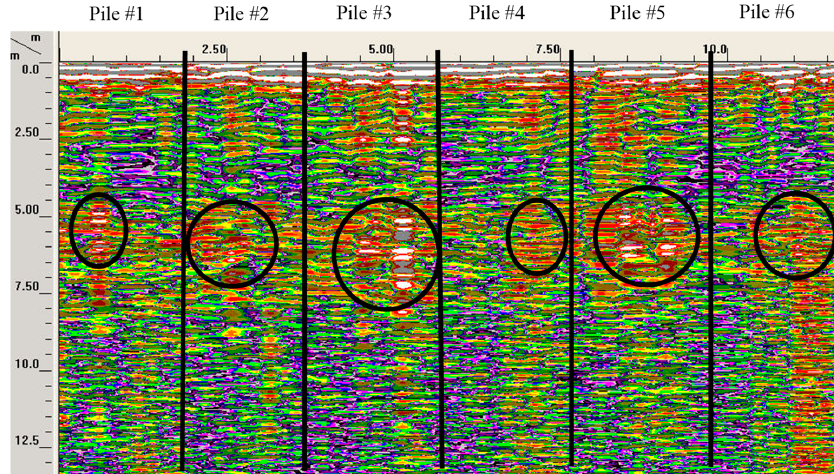
Figure 7. GPR image of 400 MHz (B-Scan).